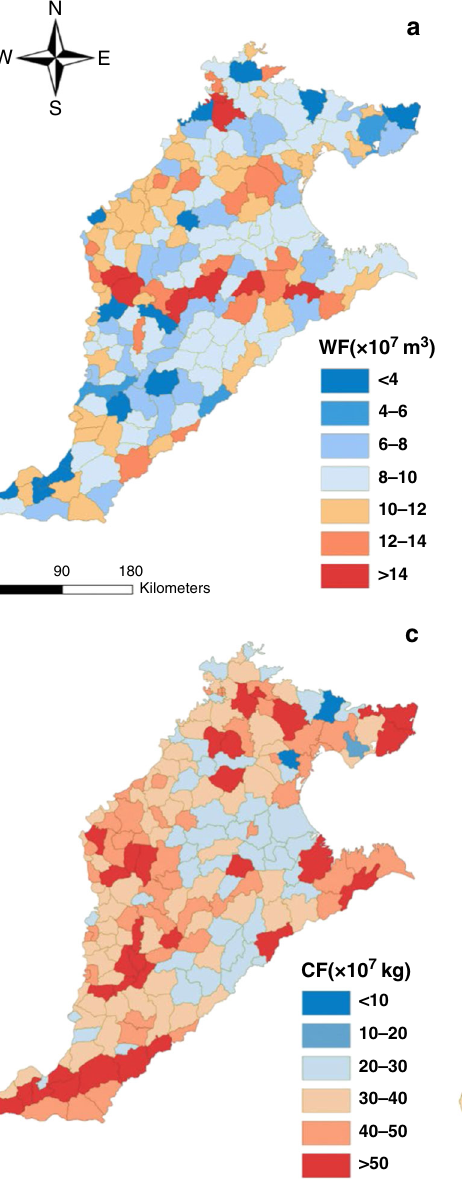
Fig. 3 Spatial dynamics of environmental impacts in the North China Plain. a Water footprint, b energy footprint, c carbon footprint and d water sustainability in irrigated agriculture of the North China Plain. The data for the base map was derived from the Resource and Environment Science and Data Center (http://www.resdc.cn/) which is public available. The boundary of the North China Plain was created by the authors (via ArcGIS version 10.1, ESRI). Data are provided in the Source data fi